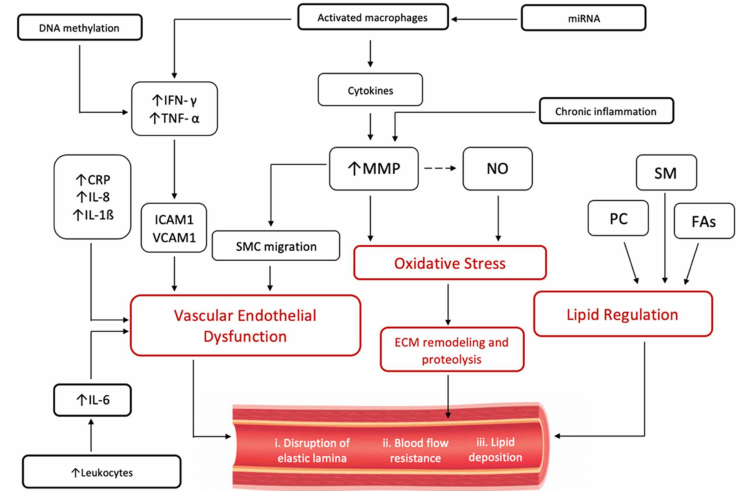
Figure 2. Schematic of proposed pathways underlying vascular remodelling in the pathogenesis of CAE. Proposed triggers such as e.g., viral or Gut microbial metabolites are not included in the figure. IFN- γ = interferon gamma; IFN- α = interferon alfa; IL-6 = interleukin-6; IL-8 = interleukin-8; IL-1 β = interleukin 1-beta; CRP = c-reactive protein; ICAM1 = Intercellular Adhesion Molecule 1; VCAM1 = Vascular Cell Adhesion Molecule 1; MMP = Matrix Metalloproteinases; SMC = smooth muscle cells; NO = nitric oxide; ECM = extracellular matrix; SM = sphingomyelin; PC = phosphatidyl- choline; FAs = fatty acids; and miRNA = microribonucleic